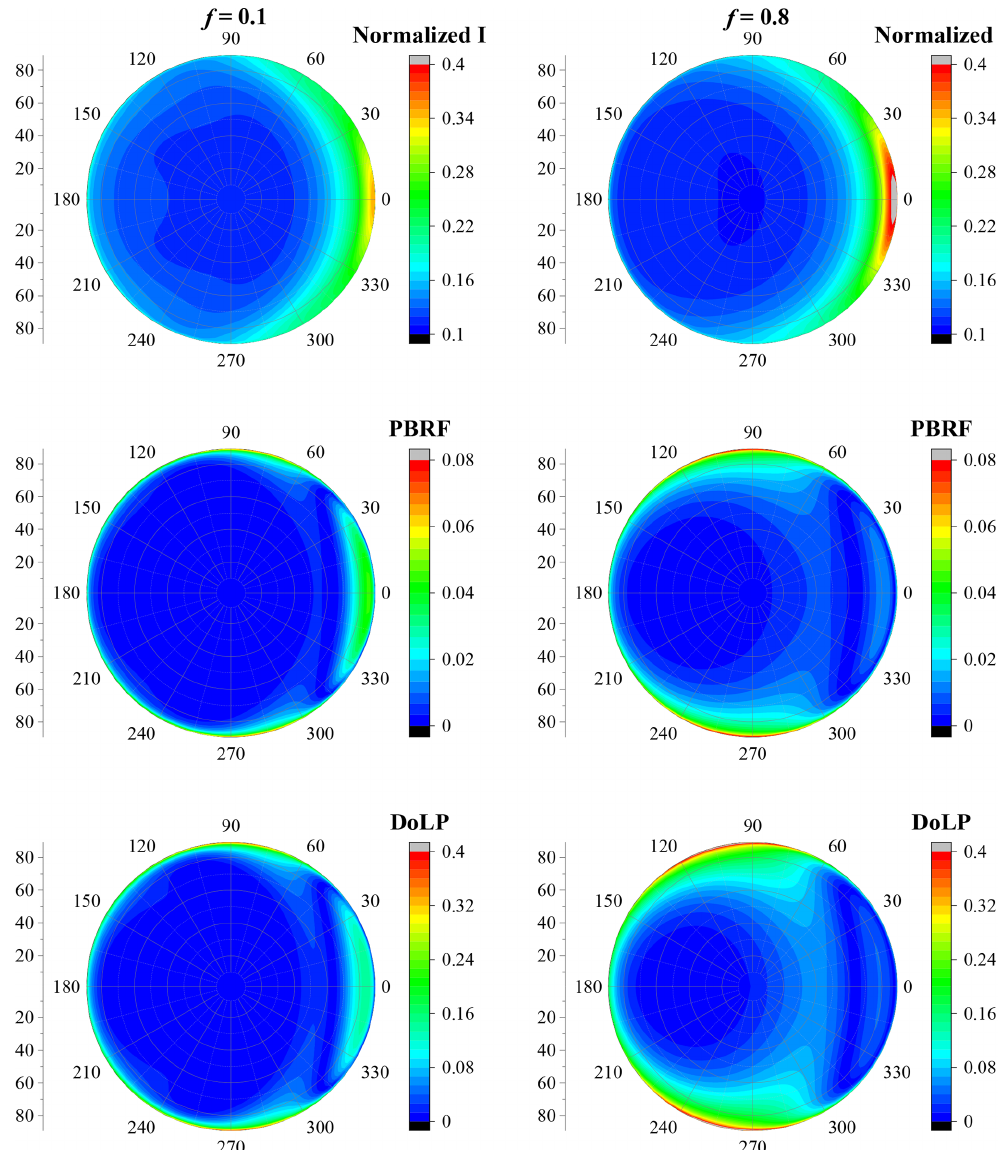
Figure 10. Similar to Fig. 9 but for d p = 0 .